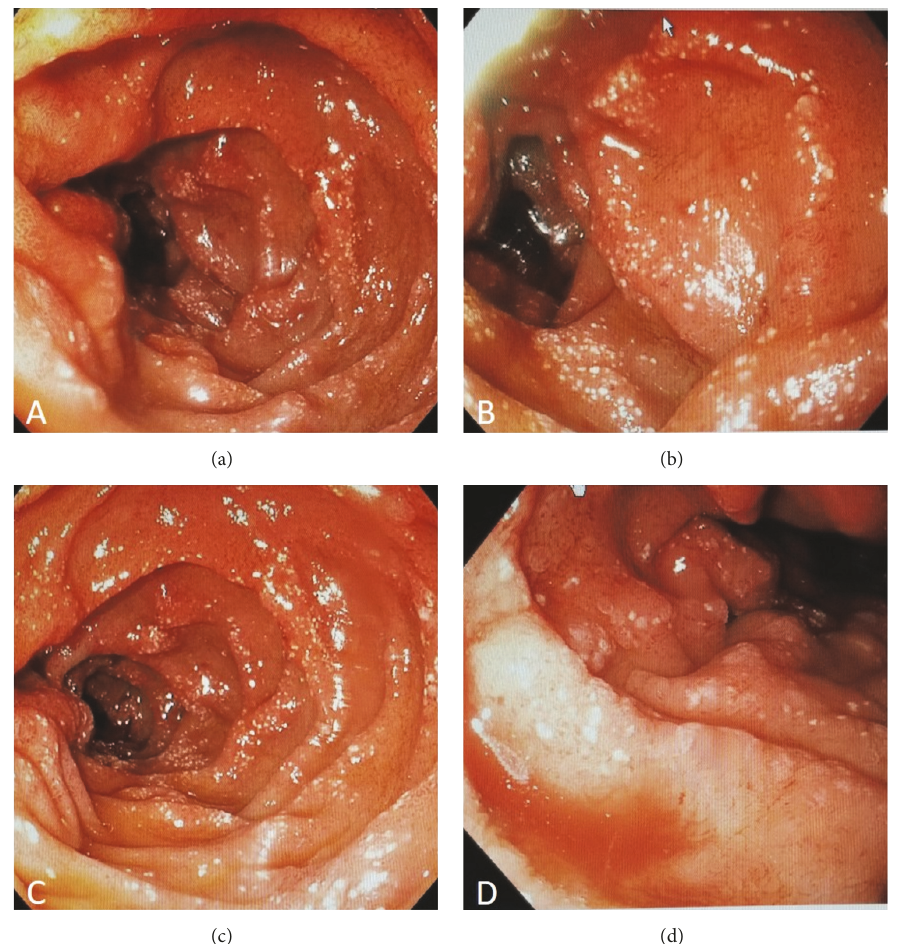
Figure 2: Endoscopic findings of erosions, mucosal erythema, and edema in the duodenum with minor oozing of blood